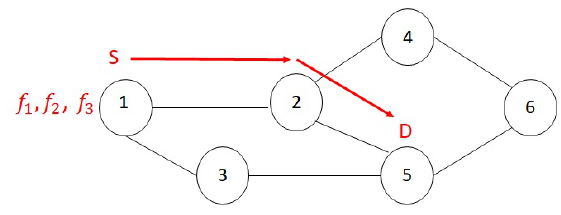
Figure 4. All shortest path placement example.